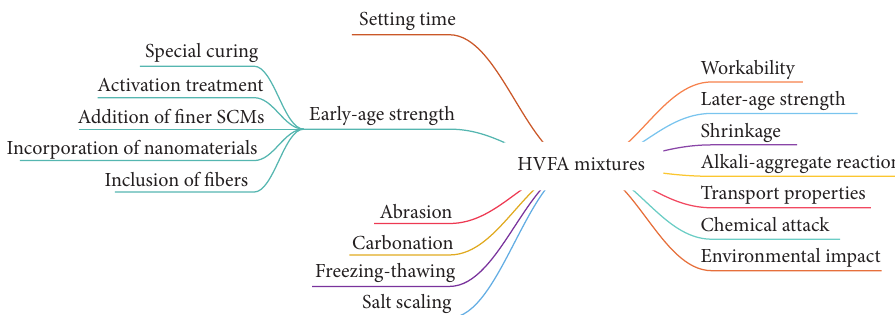
Figure 22: Renewed perspective about the superior and inferior aspects of HVFA mixtures relative to OPC